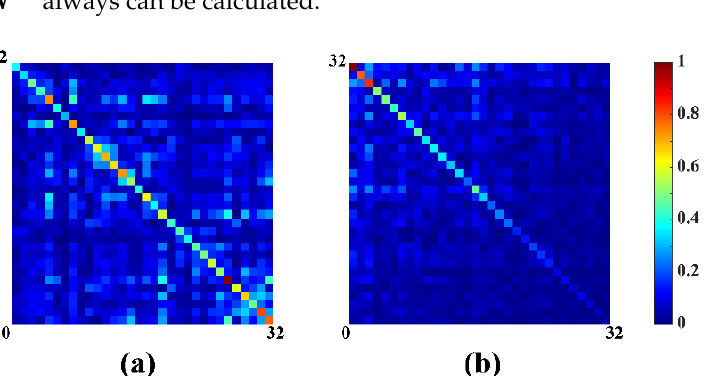
Figure 3. Noise correlation matrix of 32 coils before and after whitened. ( a ) Before whitened; ( b ) after whitened.